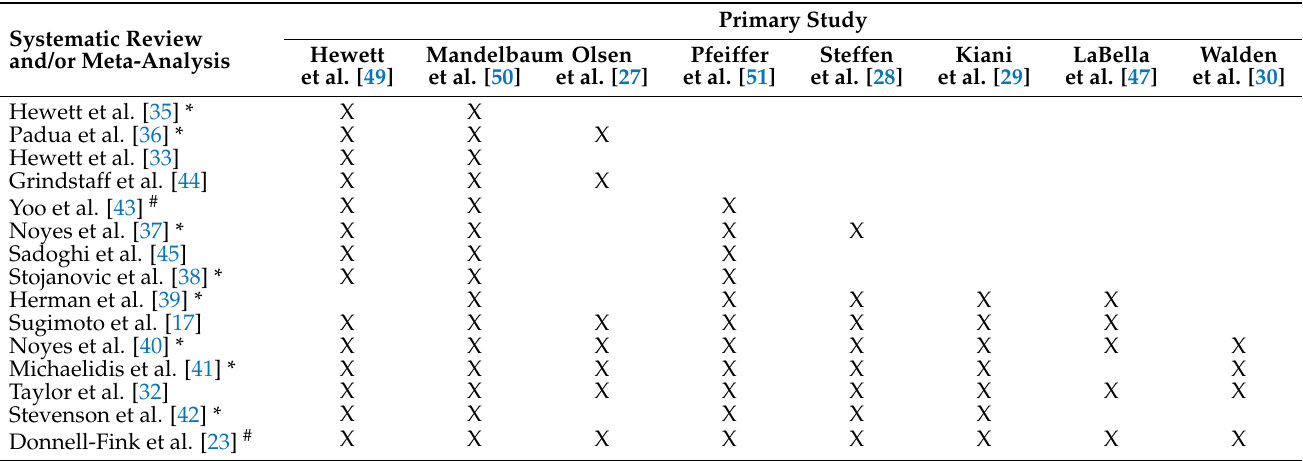
Table 3. Primary studies included in the systematic reviews and meta-analyses.